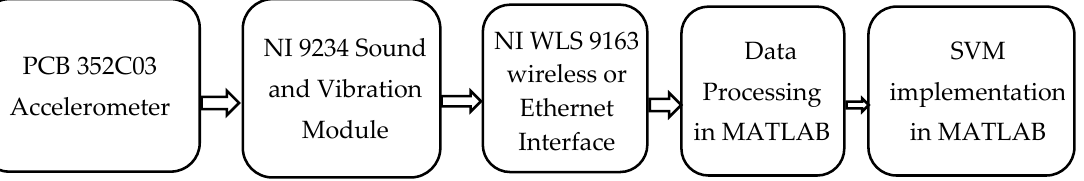
Figure 6. Workflow of the process .